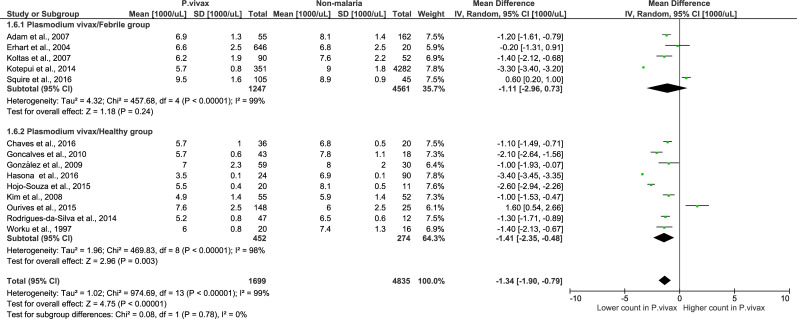
Subgroup analysis of P. vivax.Forest plot of subgroup analysis showing the total leukocyte count in P. vivax compared to febrile and healthy groups. [1000/μL] refers to 1000 per microliter; “IV" in "IV, Random” refers to Inverse variance; "Total" in top row refers to number of patients included; A green square in the horizontal line refers to the mean difference for each of included study.